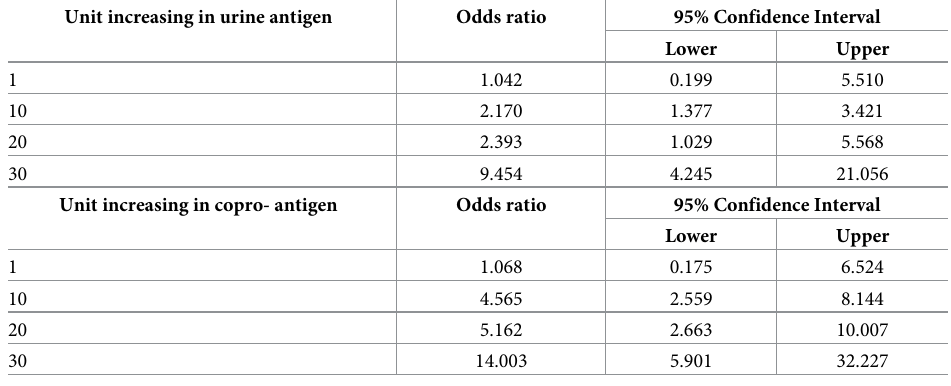
Table 6. Prediction of human opisthorchiasis by increasing urine and copro-antigen